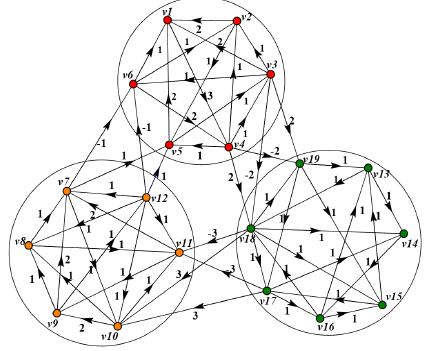
Figure 2. The outer coupling matrix G .